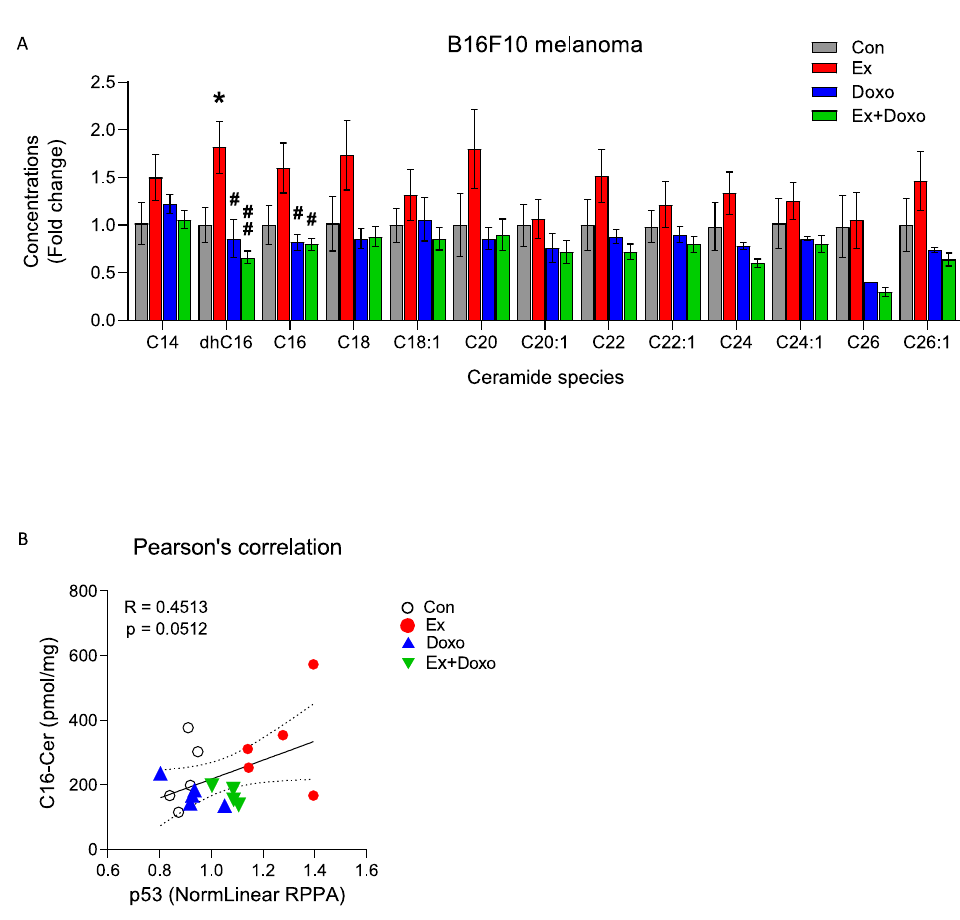
Figure 2. Exercise increases dhC16-ceramide and C16-ceramide levels in B16F10 tumors. ( A ) Liquid chromatography–mass spectrometry (LC/MS) quantification of multiple ceramide species in B16F10 tumors. One-way ANOVA, followed by post hoc tests, was performed to compare differences among groups for each ceramide species ( n = 5 or 6). ( B ) Pearson’s correlation analysis shows a positive correlation between p53 protein expression and C16-ceramide concentrations determined by RPPA and LC/MS, respectively ( n = 4–6). Data are shown as mean ± SEM. * p < 0.05; # p < 0.05; ## p < 0.01 vs.